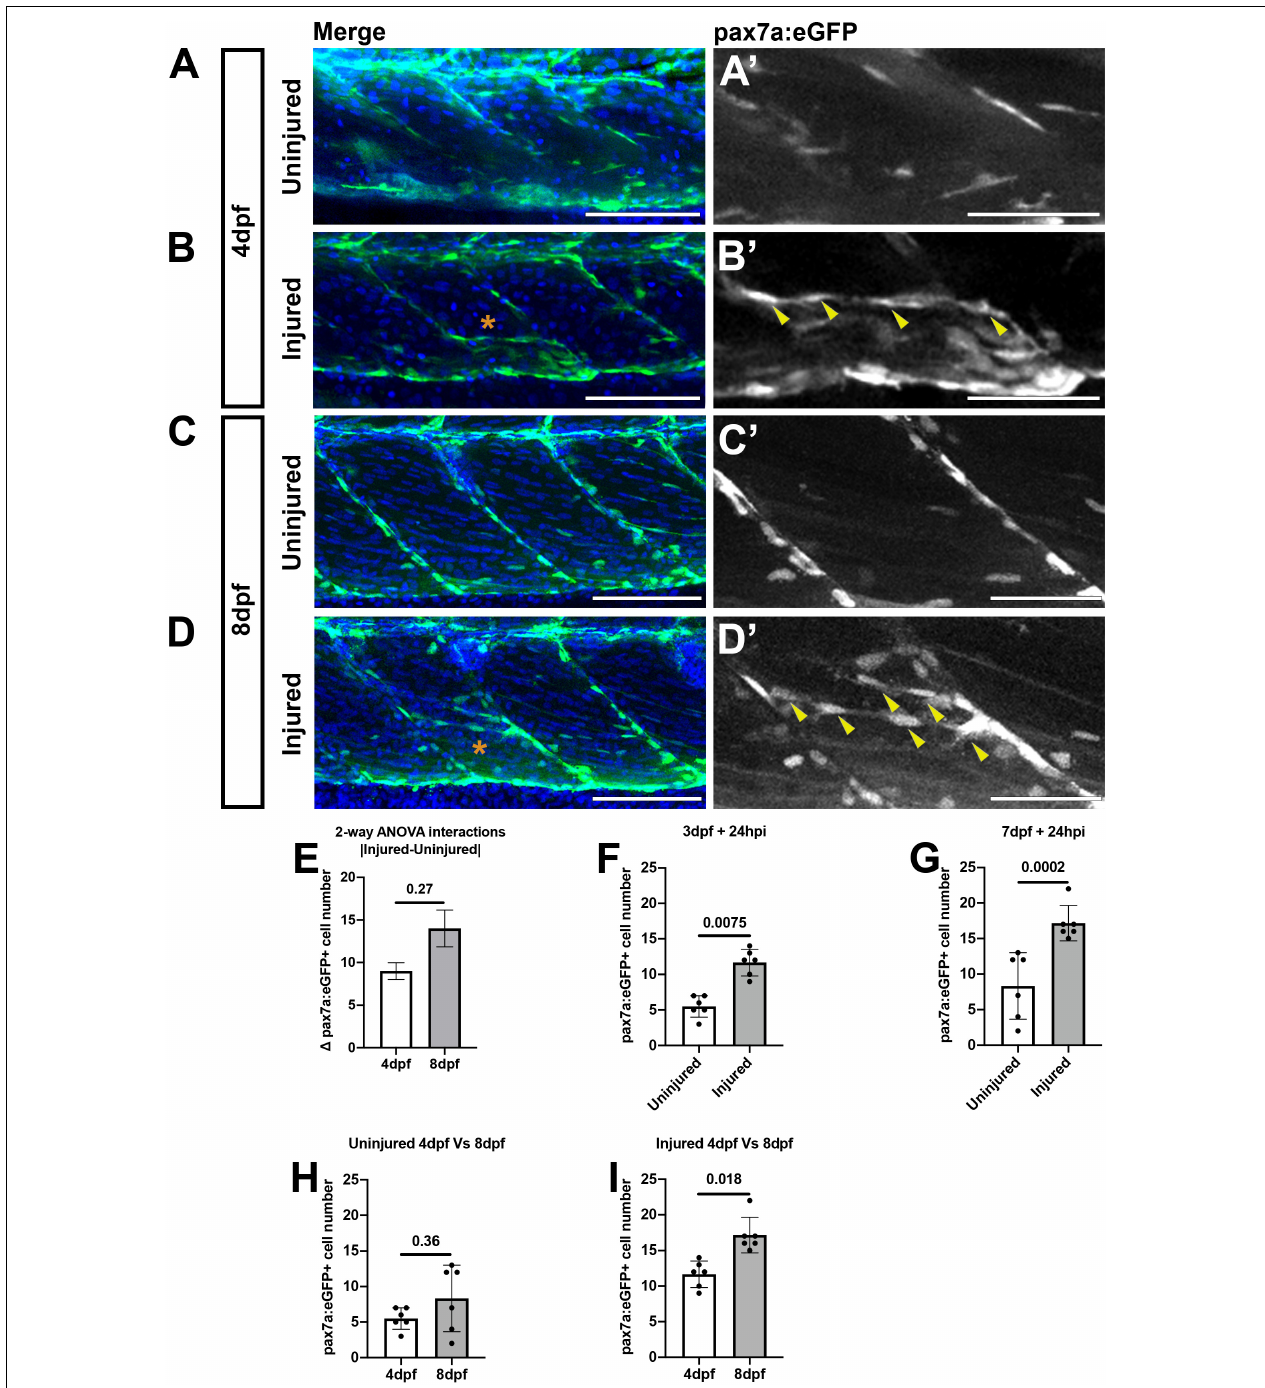
FIGURE 3 | Muscle injury results in an increased number of pax7a:egfp-expressing cells within the myotome at 3 and 7 dpf. Projections of confocal z-stacks of the myotome in uninjured (A,C) and injured (B,D) 3 or 7 dpf pax7a:eGFP larvae at 24 hpi with nuclei labeled with DAPI. MuSCs (arrowheads) are recruited to the site of injury (asterisk) and align with myofibres at both stages (A’–D’) . Quantification of pax7a:egfp-expressing muSCs in uninjured and injured 3 and 7 dpf larvae at 24 hpi. The magnitude of change to the number of muSCs responding to injury ( (cid:49) pax7a:egfp+) is significantly different between 4 and 8 dpf larvae ( p > 0.05, E ). Pairwise comparisons reveals a significant increase in the number of muSCs at both stages as a consequence of injury ( p < 0.05, F,G ). There is no significant difference in the number of muSCs between uninjured animals at 4 and 8 dpf (H) , but there are more muSCs in injured 8 dpf larvae relative to injured 4 dpf larvae ( p < 0.05, I ). Significant differences were tested by 2-way ANOVA ( n = 47) with Tukey’s HSD post hoc test. Error bars represent standard deviation, and values above comparison bars represent significance ( p -values). Scale bars: 100 µ m (A–D) , 50 µ m (A’–D’) .